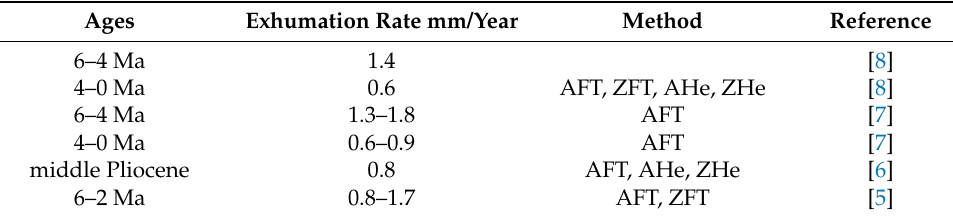
Table 1. Summary of the Alpi Apuane exhumation rate estimated in previous studies. Ages Exhumation Rate mm/Year Method